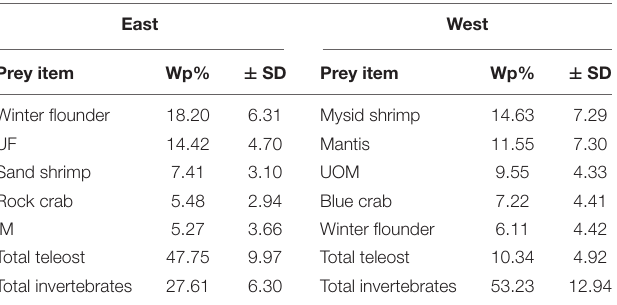
TABLE 7 | Top five prey items for summer flounder collected in Shinnecock Bay based on bay region (East and West) and the total amount of teleost and